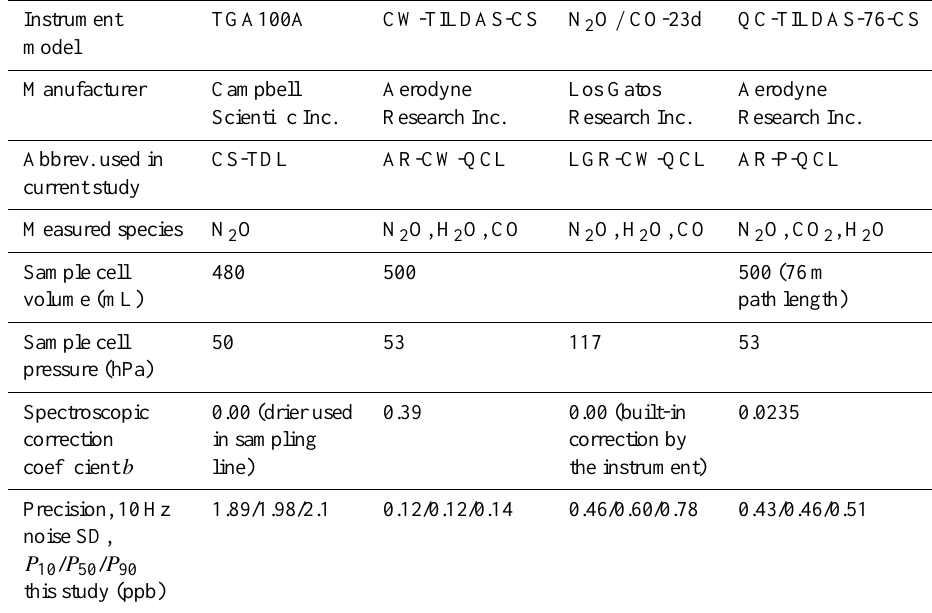
Table 1. Instrumental characteristics. Experimental precision values are based on flux measurements during the period DOY 206–271 (period II). TDL – tunable diode laser; CW-QCL – continuous-wave quantum cascade laser; P-QCL – pulsed QCL. P 10 /P 50 /P 90 represent the lower percentile, median and upper percentile